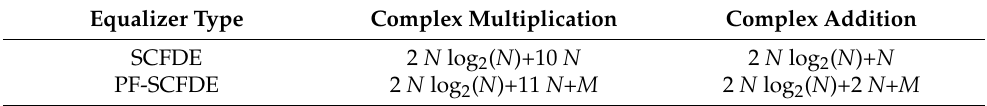
Table 1. Computational complexity comparison between SCFDE and